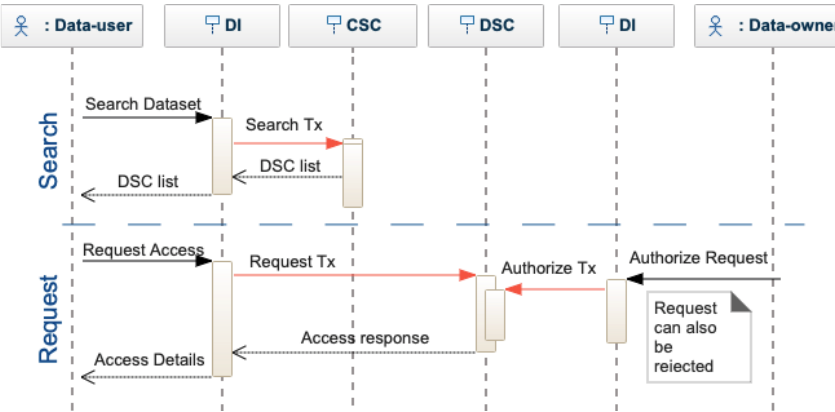
Figure 6. Sequence diagram for dataset search and access request.